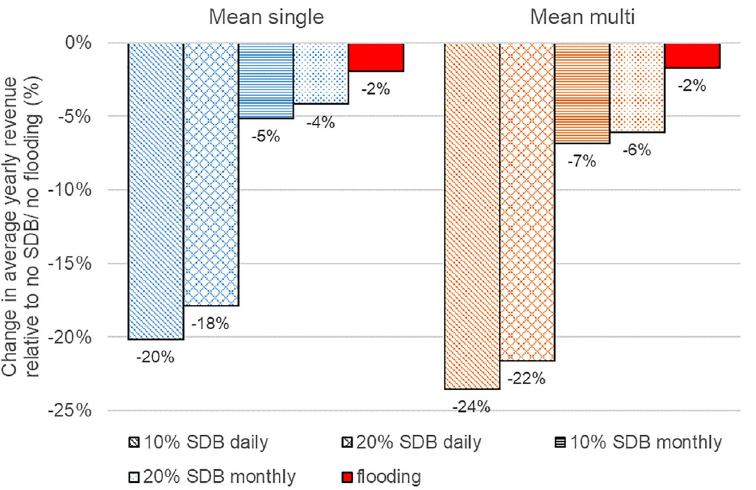
Fig 6. Change in average yearly revenue by daily and monthly SDBs and environmental flows (flooding). Based on yearly revenues for the period 2012 to 2015. SDBs represent 10% and 20% allowable deviations from the natural flow on daily or monthly basis. The environmental flows (flooding) are based on the magnitude, frequency, and timing of the environmental flows in the comparable river Spo¨l.